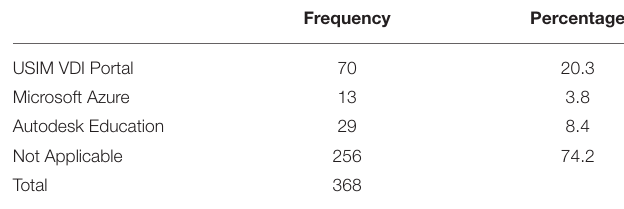
TABLE 10 | Frequency of usage the learning space among the students (Before COVID-19 pandemic).